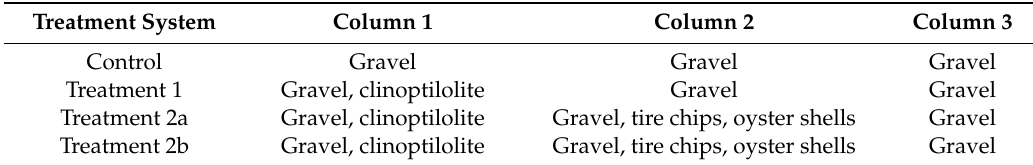
Table 3. Media in each treatment column.